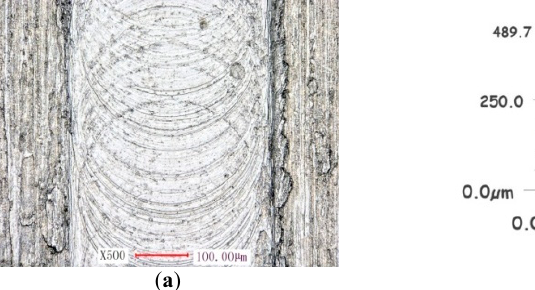
Figure 14. The micro groove surface topography for Ti-6Al-4V with run out. ( a ) Surface of micro groove. ( b ) Topography of micro groove.